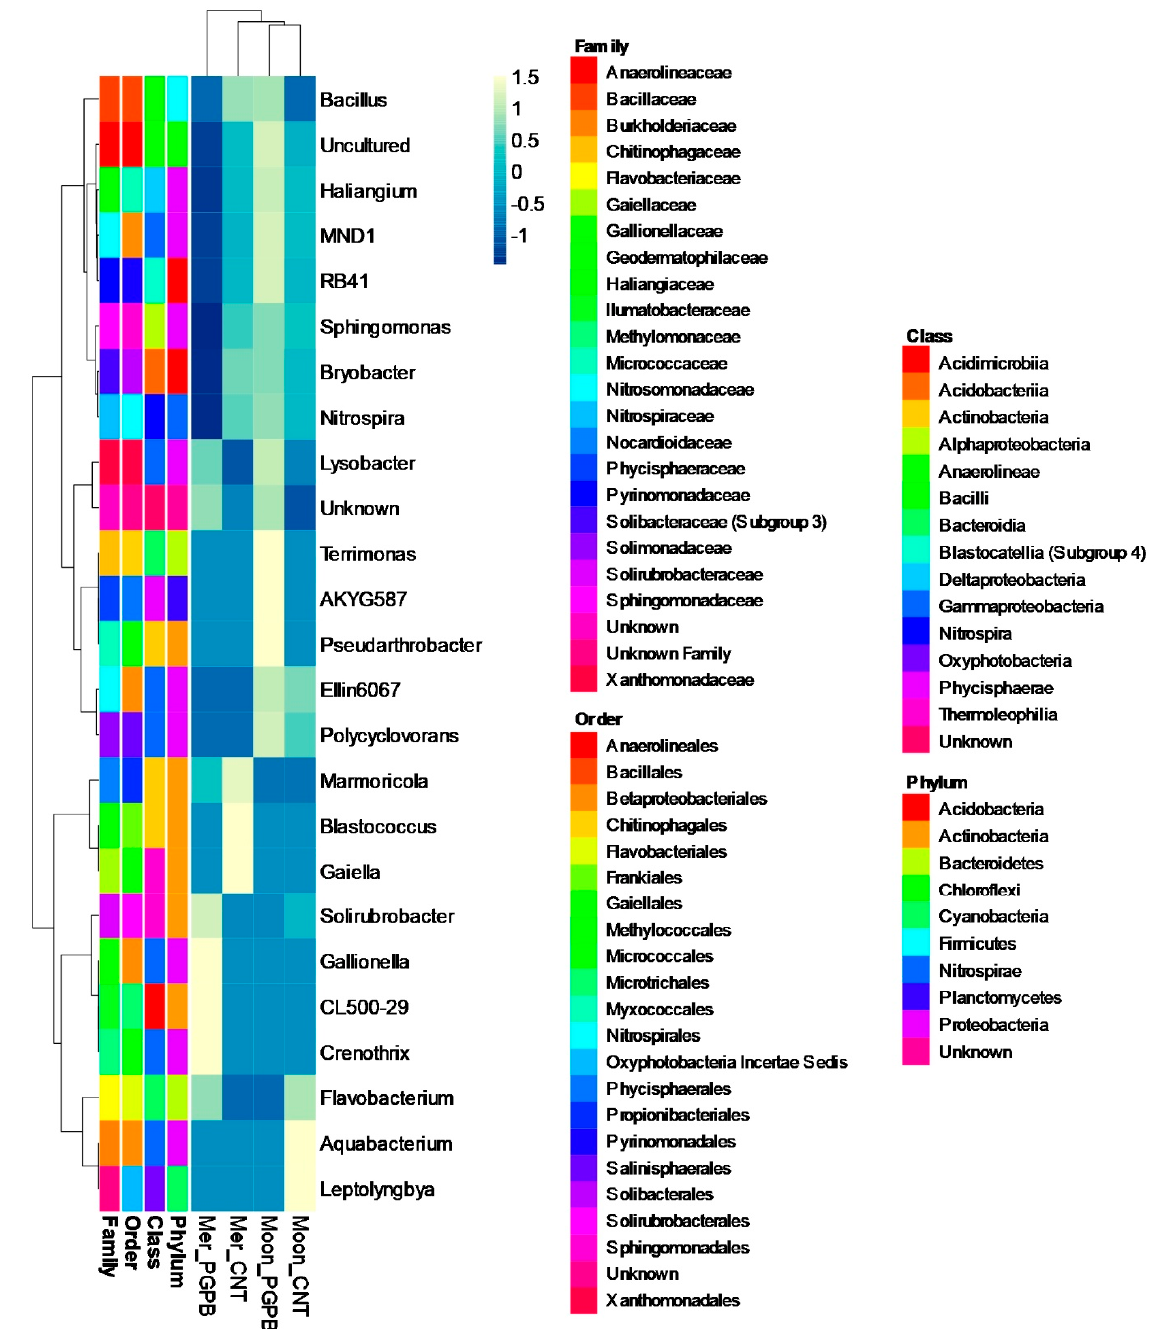
Figure 6. Heat-map and clustering of the soil microbial community composition of the Control (CNT) and treated (PGPB) experimental conditions of Meranto (Mer) and Moondance (Moon) crops. The color changes in the panel show the percentage occupied by the genus inside each sample (color scale at the top). Taxonomy is indicated by the color keys on the right.